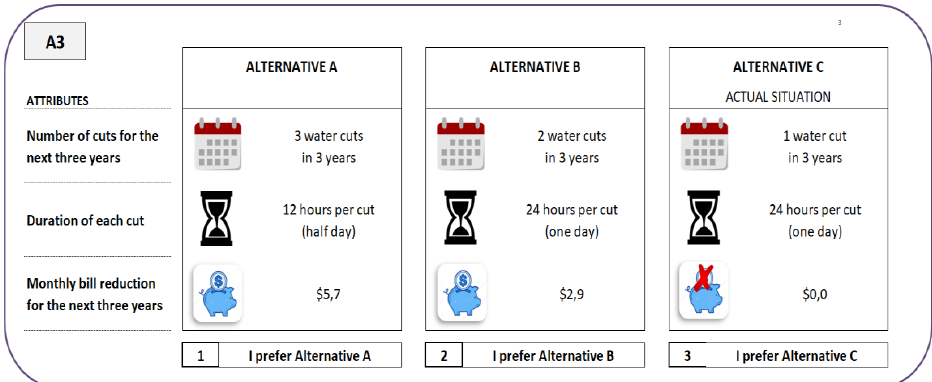
Figure 3. Example of choice scenarios.